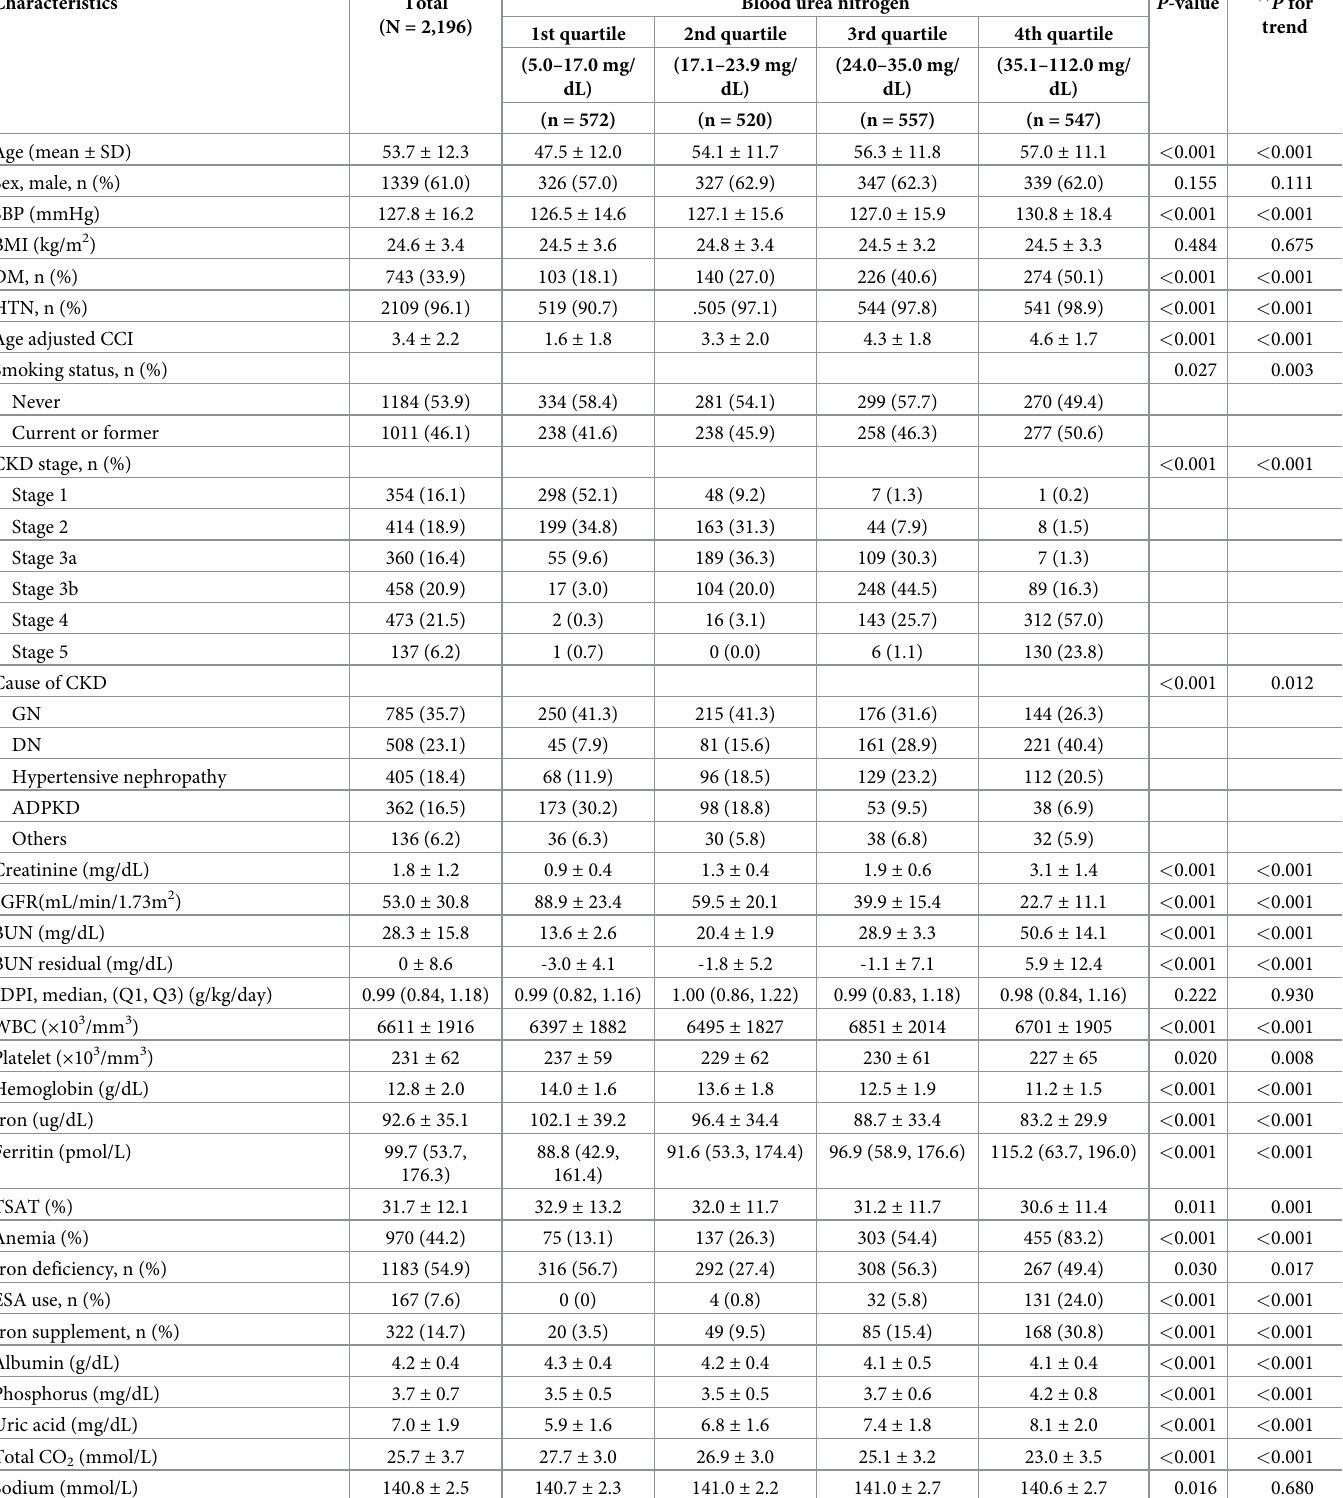
Table 1. Clinical characteristics of the study subjects at enrollment stratified by BUN levels.